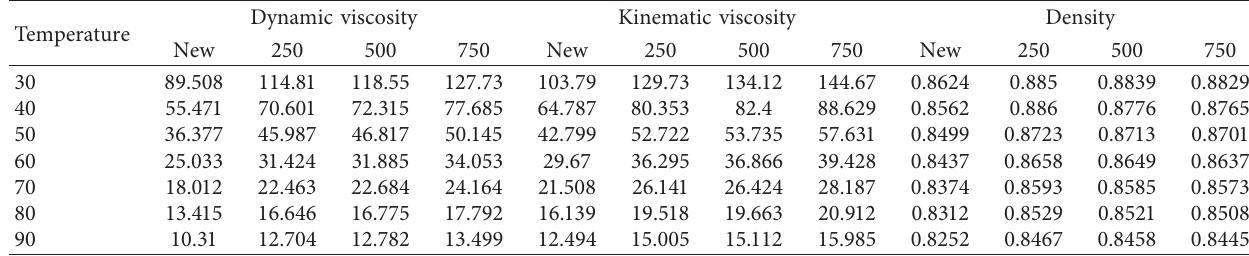
Table 2: Experimental readings of oil samples.